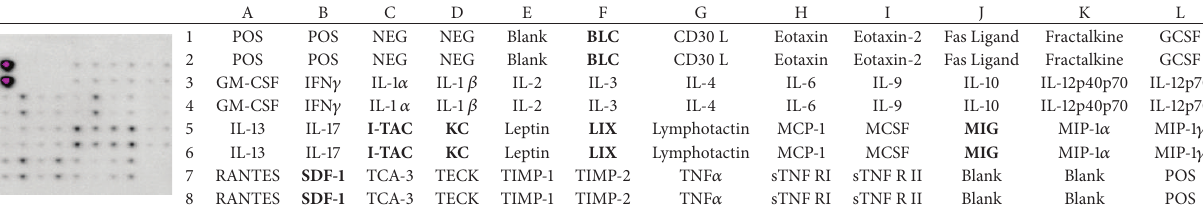
Table 1: We used RayBio Mouse Inflammation Antibody Array 1